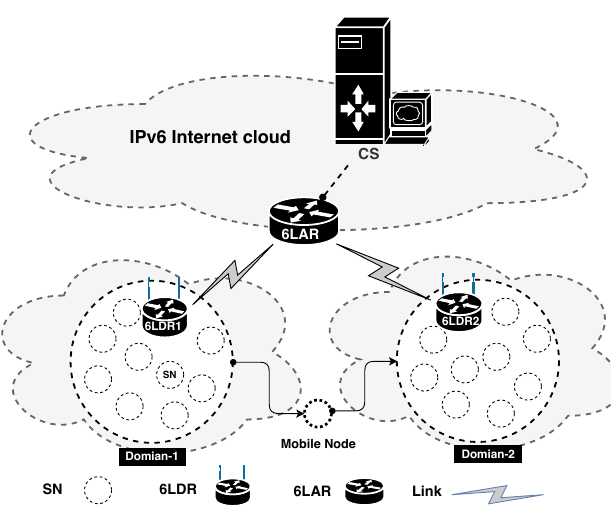
Figure 1. 6LoWPAN network